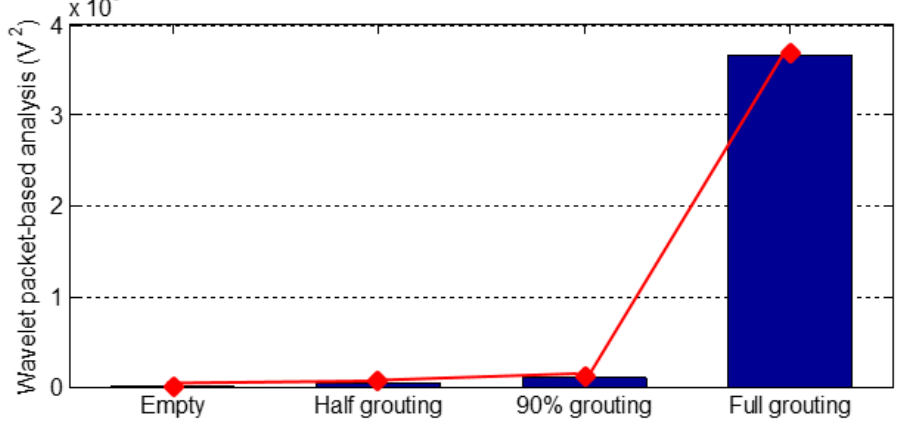
Figure 14. Wavelet packet-based energy analysis of PZT 2 located on the top surface.